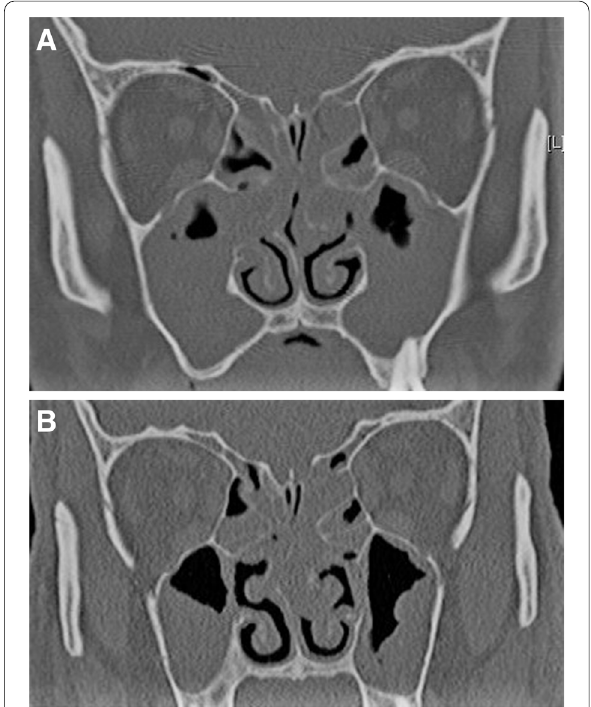
Fig. 1 Two consecutive PNSCT images in coronal sections. A Taken in May 2019, partial and mild demineralization areas with osteopenia are seen in the ethmoid cell walls. B PNSCT section taken 15 months later in September 2020 and crossing approximately the same level of ethmoid cells. The patient has been using 3 courses of irregular nasal steroids in this 15-month period. This slice of PNSCT was interpreted as a slight increase in